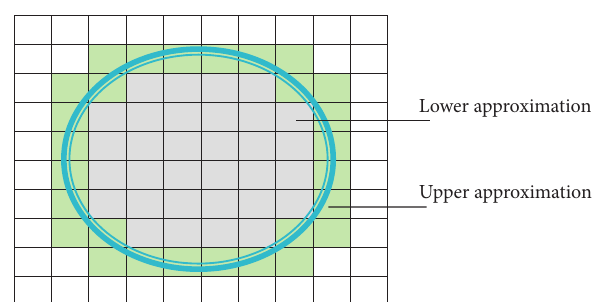
Figure 1: Concept of rough